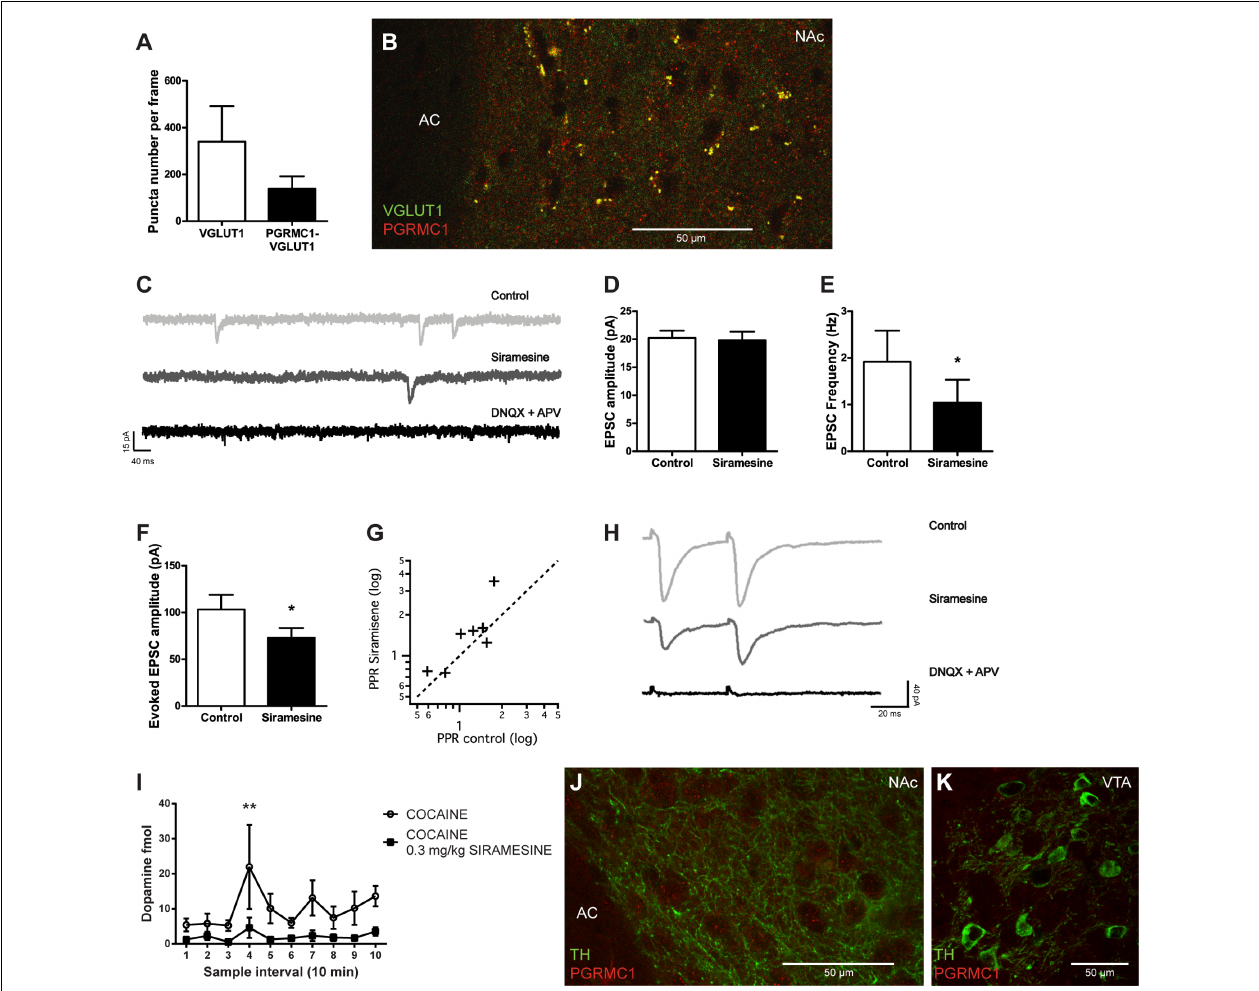
FIGURE 5 | Effects of Siramesine on glutamate release probability in the nucleus accumbens and dopamine input to the striatum. Mean ± SEM of (A) numbers of VGLUT1 expressing boutons vs VGLUT1 boutons co-localized with PGRMC1/ σ 2R puncta in the NAc ( n = 4). (B) A 63 × confocal image showing co-localization of VGLUT1 (green) and PGRMC1/ σ 2R (red) in terminals adjacent to cell somas of NAc near the anterior commissure (AC). (C) Spontaneous EPSCs before and after bath-application of drugs. Siramesine decreases the frequency of spontaneous events, while DNQX and APV abolishes them completely. (D) Siramesine does not affect the amplitude of spontaneous EPSCs (E) but significantly decreases their frequency as represented in mean ± SEM ( n = 8). (F) Siramesine decreases the amplitude of the first evoked EPSCs ( n = 8), (G) and increases the paired pulse ratio (PPR) in six out of eight cells. (H) Example traces from the paired pulse stimulus, showing how Siramesine reduces EPSC amplitude and increases PPR. Evoked EPSCs are abolished by DNQX and APV. (I) Dopamine concentrations in the striatum (NAc and CPu) prior to and following cocaine administration. When Siramesine was injected 30 min prior to sampling, it significantly decreased cocaine-induced dopamine levels in the striatum. Cocaine was i.p. injected at the third sample-interval (NaCl n = 8, Siramesine n = 9). (J) A 63 × confocal image of TH-positive fibers (green) and PGRMC1/ σ 2R (red) in terminals adjacent to cell somas of NAc near the anterior commissure (AC). (K) A 63 × confocal image of VTA TH-positive neurons (green) without any PGRMC1/ σ 2R (red) co-labeling of immunoreactivity. ∗ p < 0.05, ∗∗ p < 0.01. Student’s paired t -test or two-way ANOVA followed by Bonferroni’s post hoc